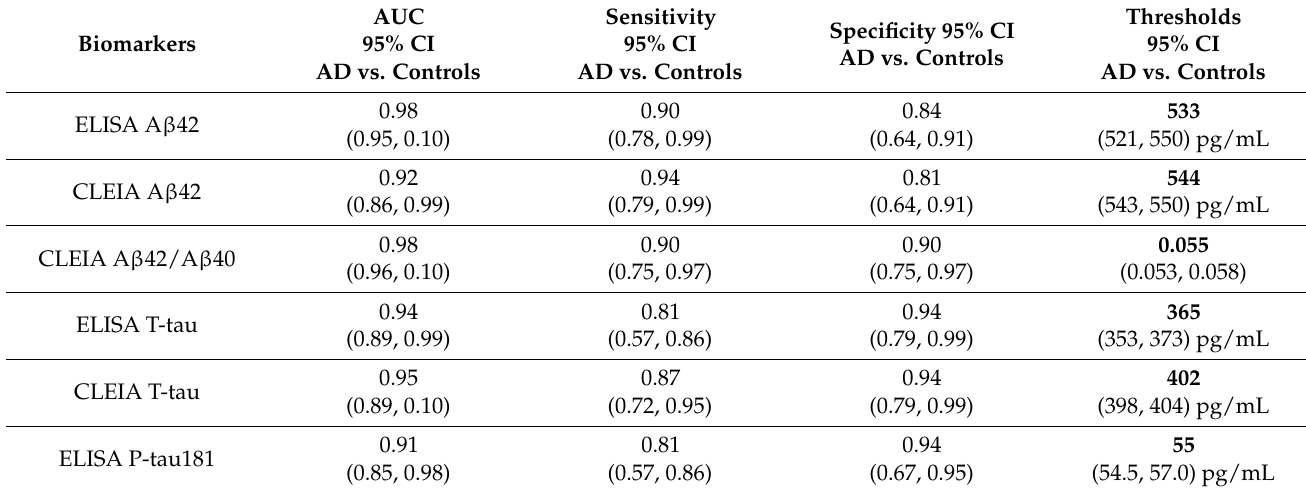
Table 2. CSF optimal thresholds and related 95% confidence intervals for ELISA and